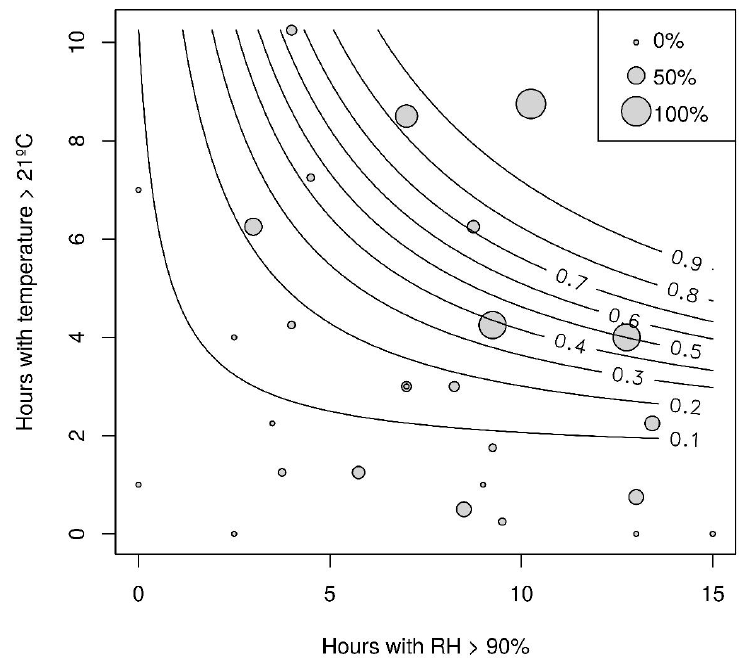
Figure 4. Combined effect of temperature and RH on sporulation of a Brazilian Neozygites floridana isolate (ESALQ 1420) from Tetranychus urticae cadavers on Jack beans in a semi-field screen house study in Piracicaba, São Paulo, Brazil, from August 2010 to November 2011. Point size is scaled by the percentage of cadavers sporulating and the lines represent the probability of sporulation from 0.1 to 0.9 (10% to 90%).